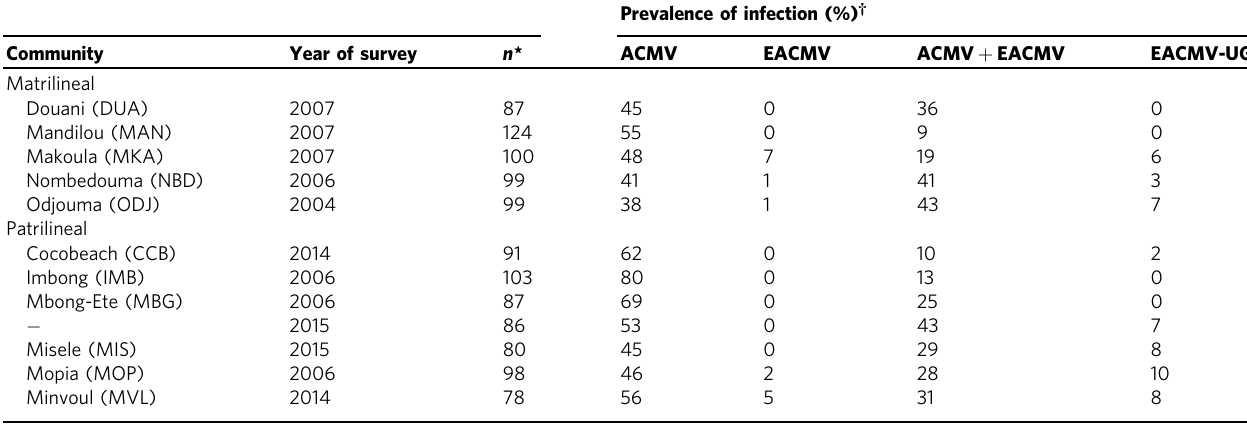
Table 2 Prevalence of CMGs in the 11 villages